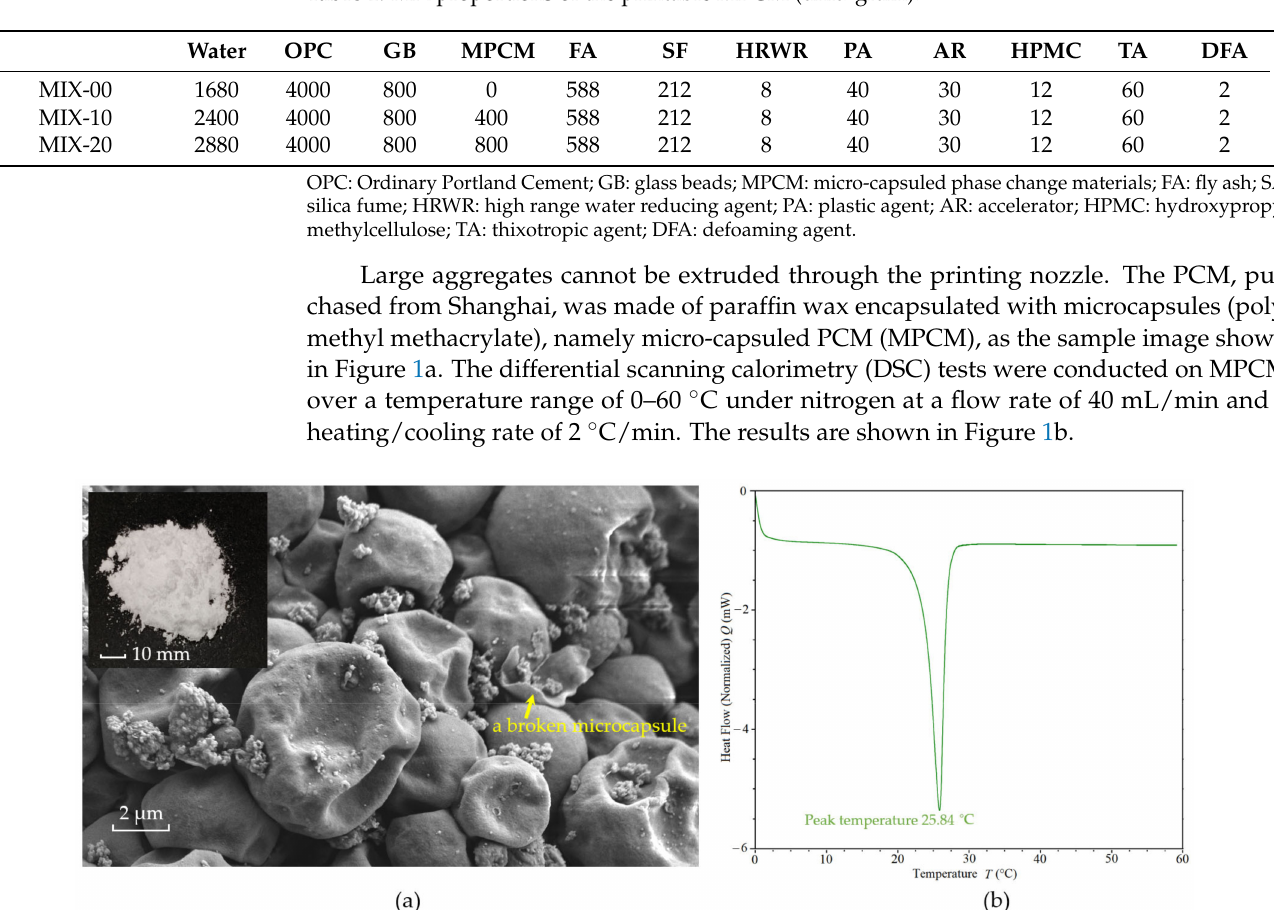
Table 1. Mix proportions of the printable MPCM (unit: gram).